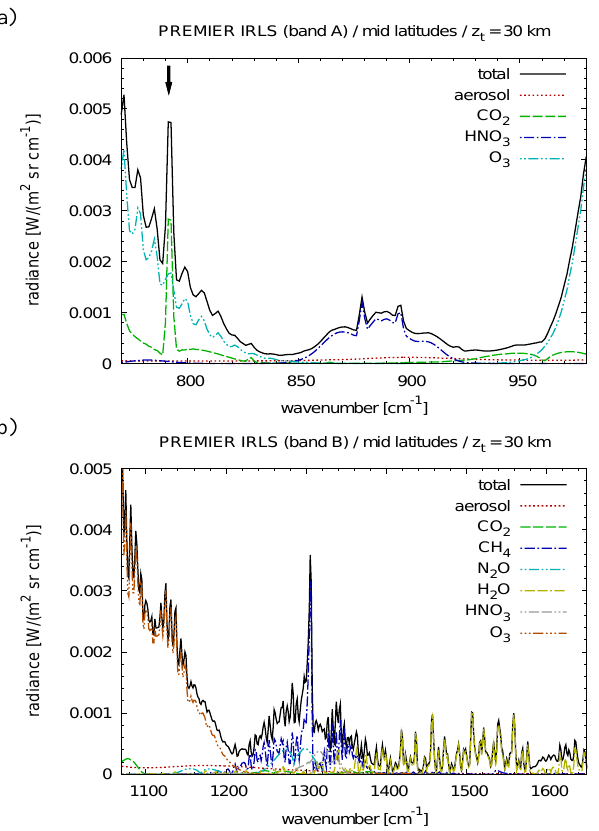
Fig. 1. Simulated radiance spectra for the PREMIER IRLS band A and B. Calculations are based on mid-latitude atmospheric condi- tions (Remedios et al., 2007) and 30km tangent altitude. The black curve indicates total radiance. The other curves indicate radiance for single emitter atmospheres (see legend). The noise level of the observations will be about 10 − 5 W/(m 2 srcm − 1 ). The black arrow indicates the CO 2 Q-branch analysed in the retrievals.